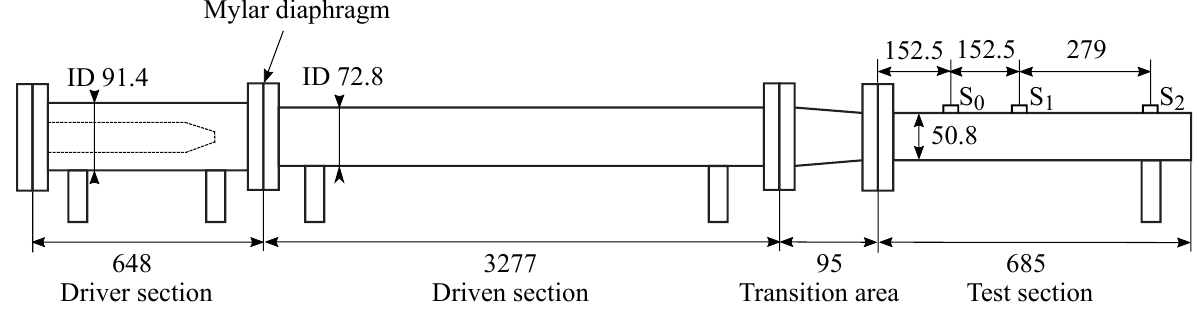
Figure 1. Schematic description of the shock tube. Both the driver and driven sections have circular cross-sections, and the test section has a rectangular cross-section. Three pressure sensors denoted S , S and S are used to measure pressure before and after the 0 1 2 foam obstacle. Dimensions in mm; not to